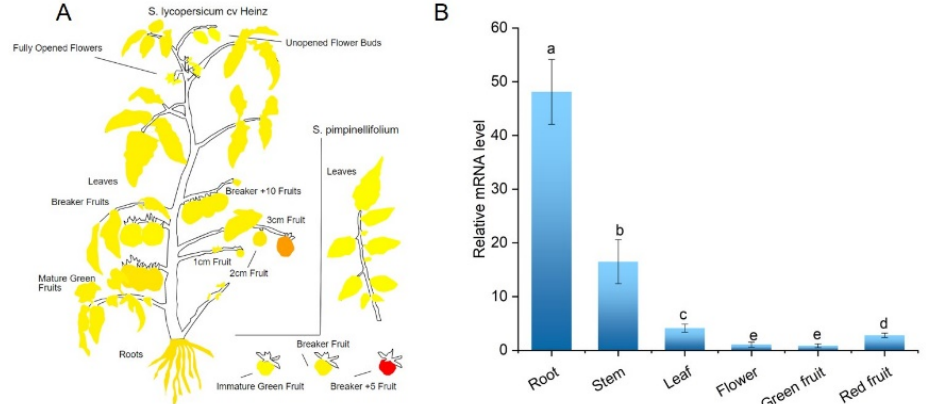
Figure 4. Expression levels of SlCML39 in different organs. ( A ) ePlant of microarray data of SlCML39 expression from bar.utoronto.ca. ( B ) The organ-specific expression of SlCML39 was detected in the root, stem, leaf, flower, green fruit, and red fruit by qRT-PCR. Total RNA was extracted from different organs. The UBI gene was used as an internal control. The bar represents the mean ± SD values of three replicates ( n = 3). According to the LSD test, the statistical differences between samples are marked with different letters ( p < 0.05).